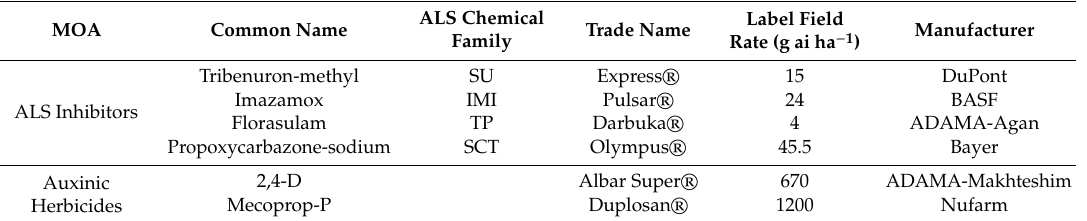
Table 1. Herbicides used in this study. ALS = acetolactate synthase; MOA = mode of action; SU